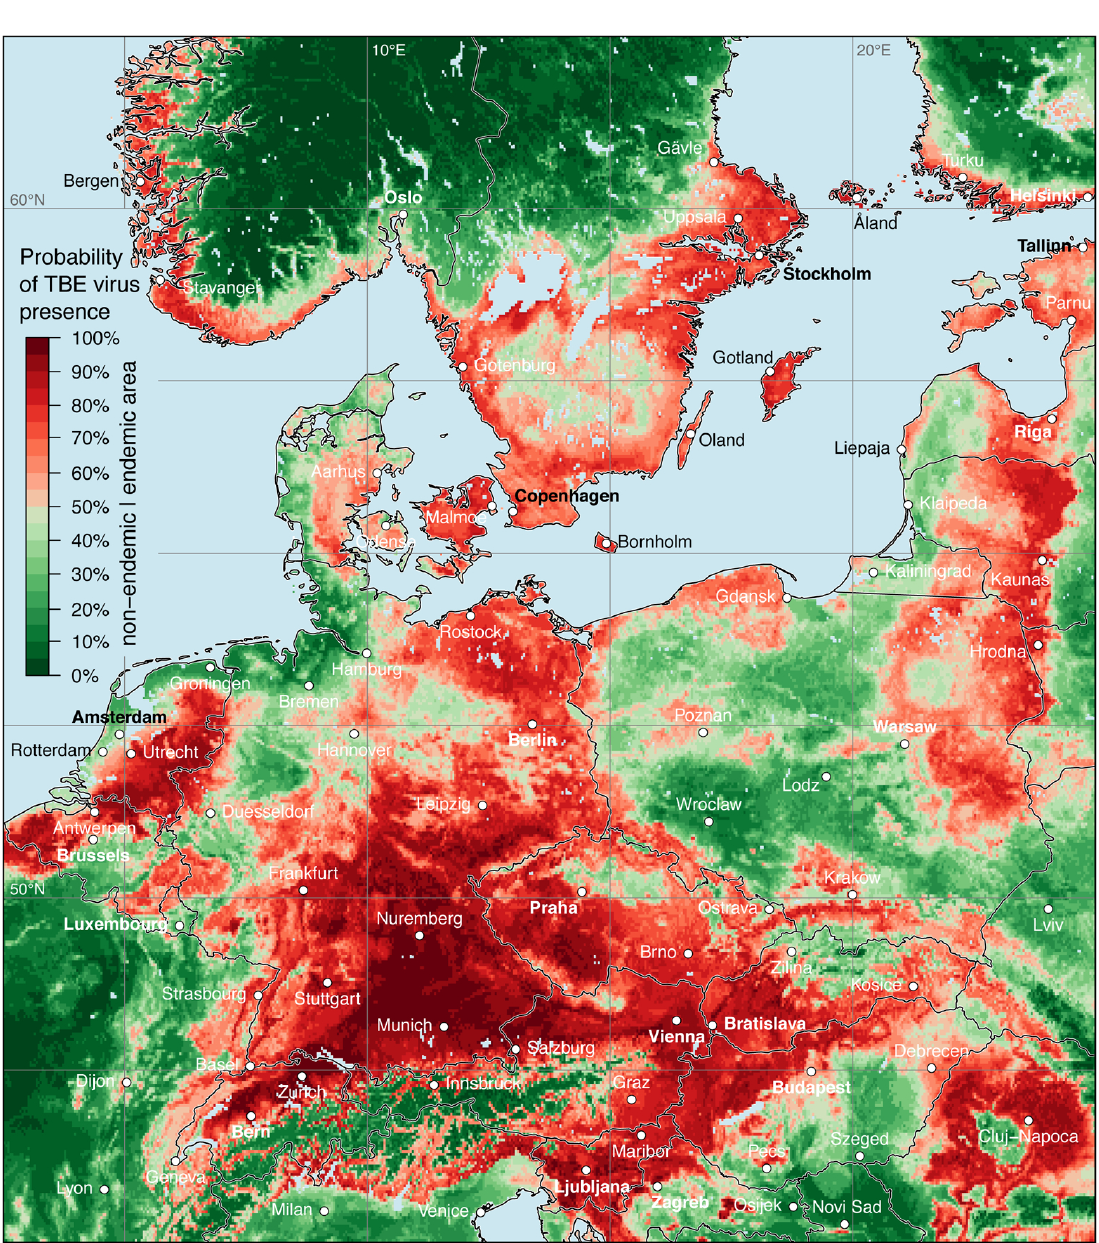
Figure 4. Probability of tick-borne encephalitis virus presence in both ticks and endothermic mammals except for humans. Endemic areas, i.e., a probability from 0.5 to 1.0, are indicated in light red to dark red and non-endemic areas are indicted from dark green to light